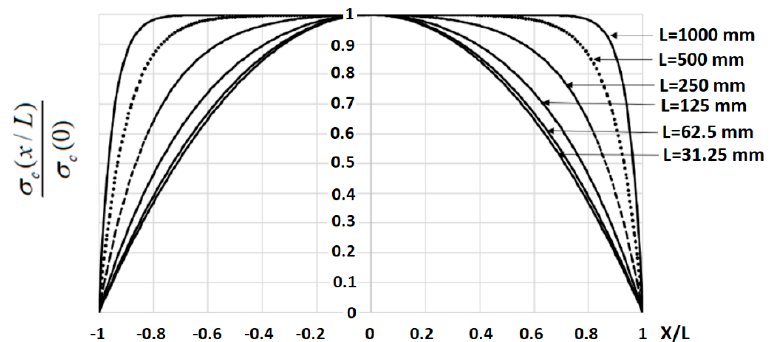
Figure 3. Variation of the tensile stress in concrete along the URCE.